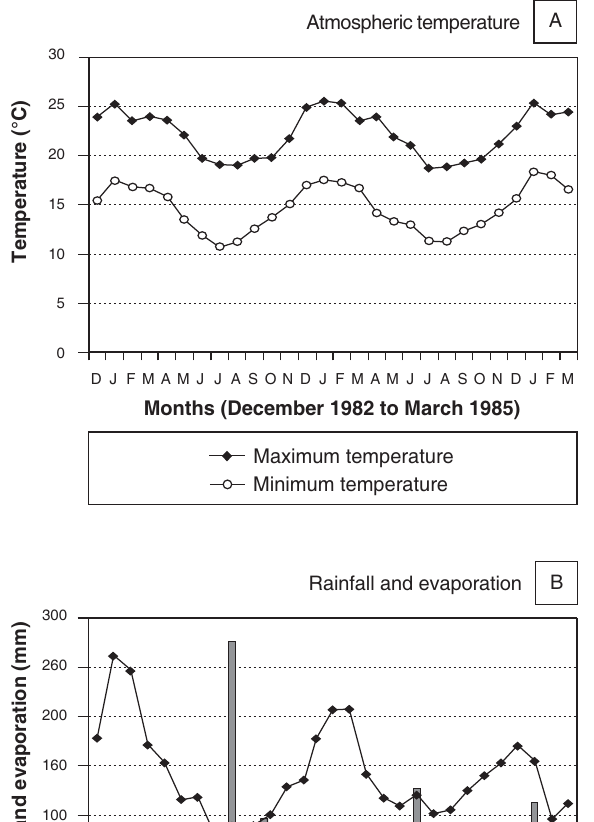
FIG. 1 Climate on the farm "Glen Dye", Eastern Cape Province. A) mean minimum and maximum atmospheric temper- atures, B) total monthly rainfall and mean monthly evap- oration, and C) mean daily hours of sunshine and wind run (km/24 h)